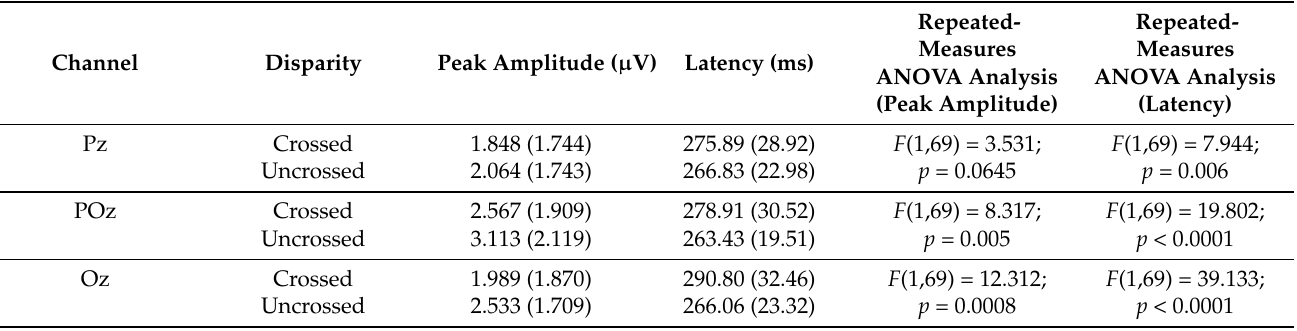
Table 1. Statistical results of component P2 characteristics with crossed and uncrossed disparities at channel Pz, POz and Oz.